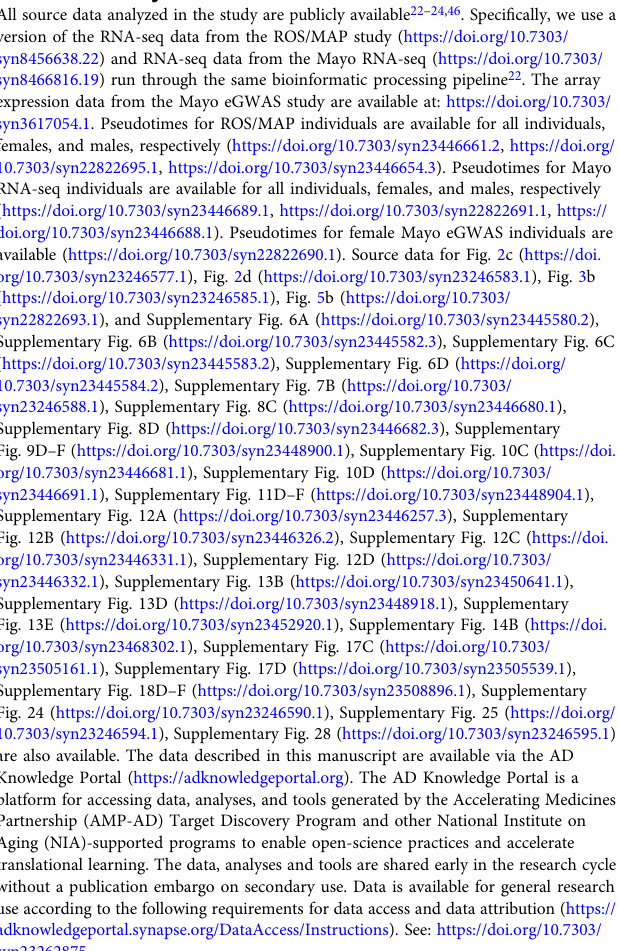
Fig. 13E (https://doi.org/10.7303/syn23452920.1), Supplementary Fig. 14B (https://doi. org/10.7303/syn23468302.1), Supplementary Fig. 17C (https://doi.org/10.7303/ syn23505161.1), Supplementary Fig. 17D (https://doi.org/10.7303/syn23505539.1), Supplementary Fig. 18D – F (https://doi.org/10.7303/syn23508896.1), Supplementary Fig. 24 (https://doi.org/10.7303/syn23246590.1), Supplementary Fig. 25 (https://doi.org/ 10.7303/syn23246594.1), Supplementary Fig. 28